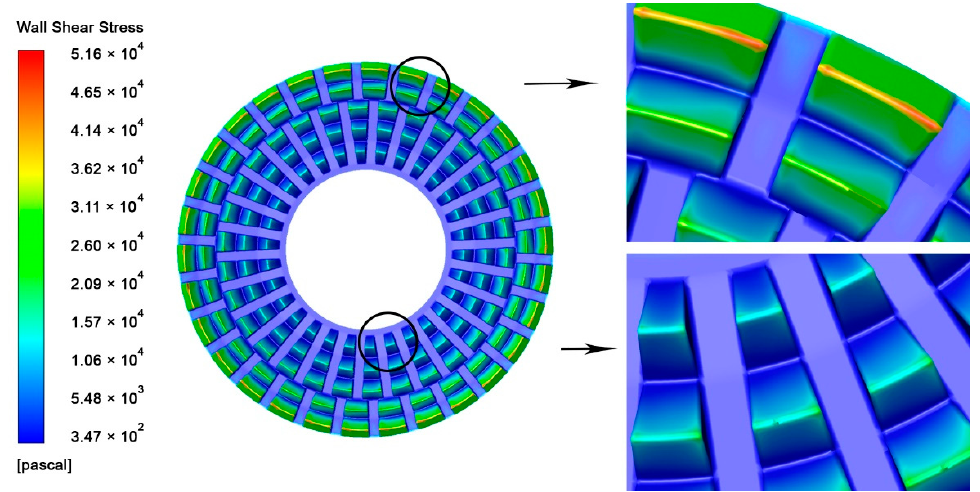
Figure 5. Shear stress on the surface of the stator.